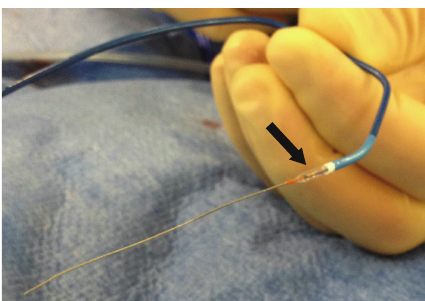
Figure 2: The BAT assembly: Kimny guiding catheter, protruding balloon (black arrow), and Sion guide